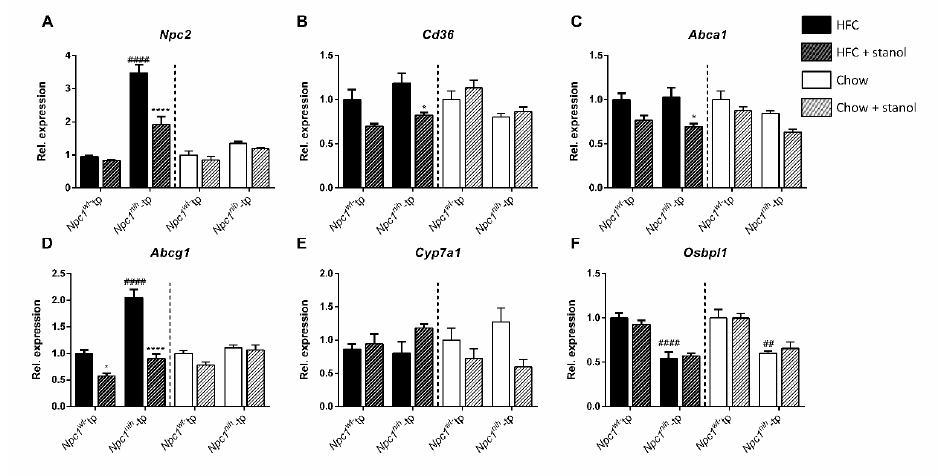
Figure 4. Hepatic lipid metabolism-related gene expression: HFC and chow diets. Hepatic gene expression levels of ( A ) Npc2 , ( B ) Cd36 , ( C ) Abca1 , ( D ) Abcg1 , ( E ) Cyp7a1 , and ( F ) Osbpl1 . n = 6–8 mice per group. All error bars represent standard error of the mean. Statistical significance is indicated as follows: Npc1 wt -tp mice on a HFC or chow diet vs. Npc1 wt -tp mice on a HFC or chow diet (## p < 0.01; #### p < 0.0001); Npc1 nih -tp or Npc1 nih -tp on a HFC or chow diet vs. Npc1 wt -tp or Npc1 nih -tp mice on a plant stanol-enriched HFC or chow diet (* p ≤ 0.05; **** p < 0.0001).